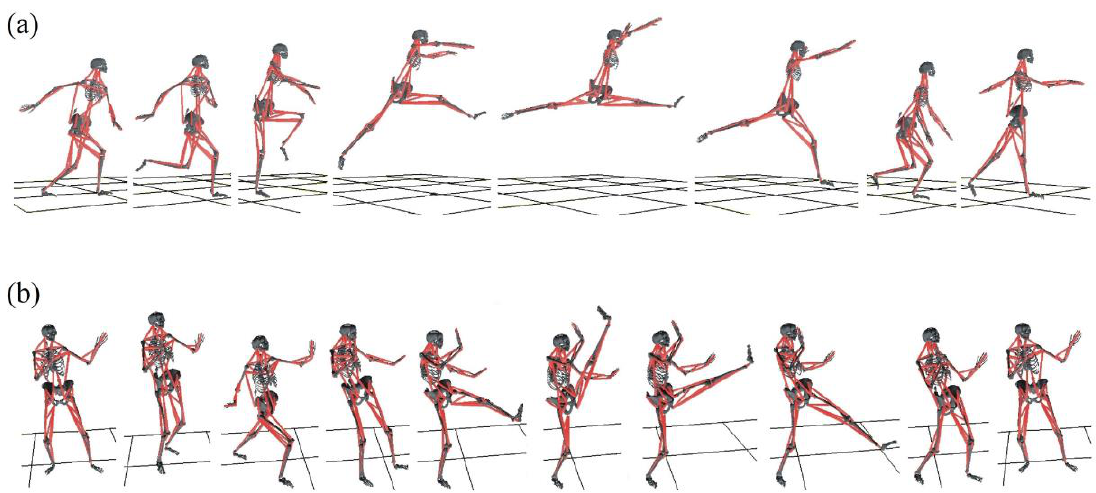
Figure 1. 15-segment biomechanical modeling of the Grande Jeté ( a ) in Ballet and the Axe Kick ( b ) in Taekwondo [56,81].